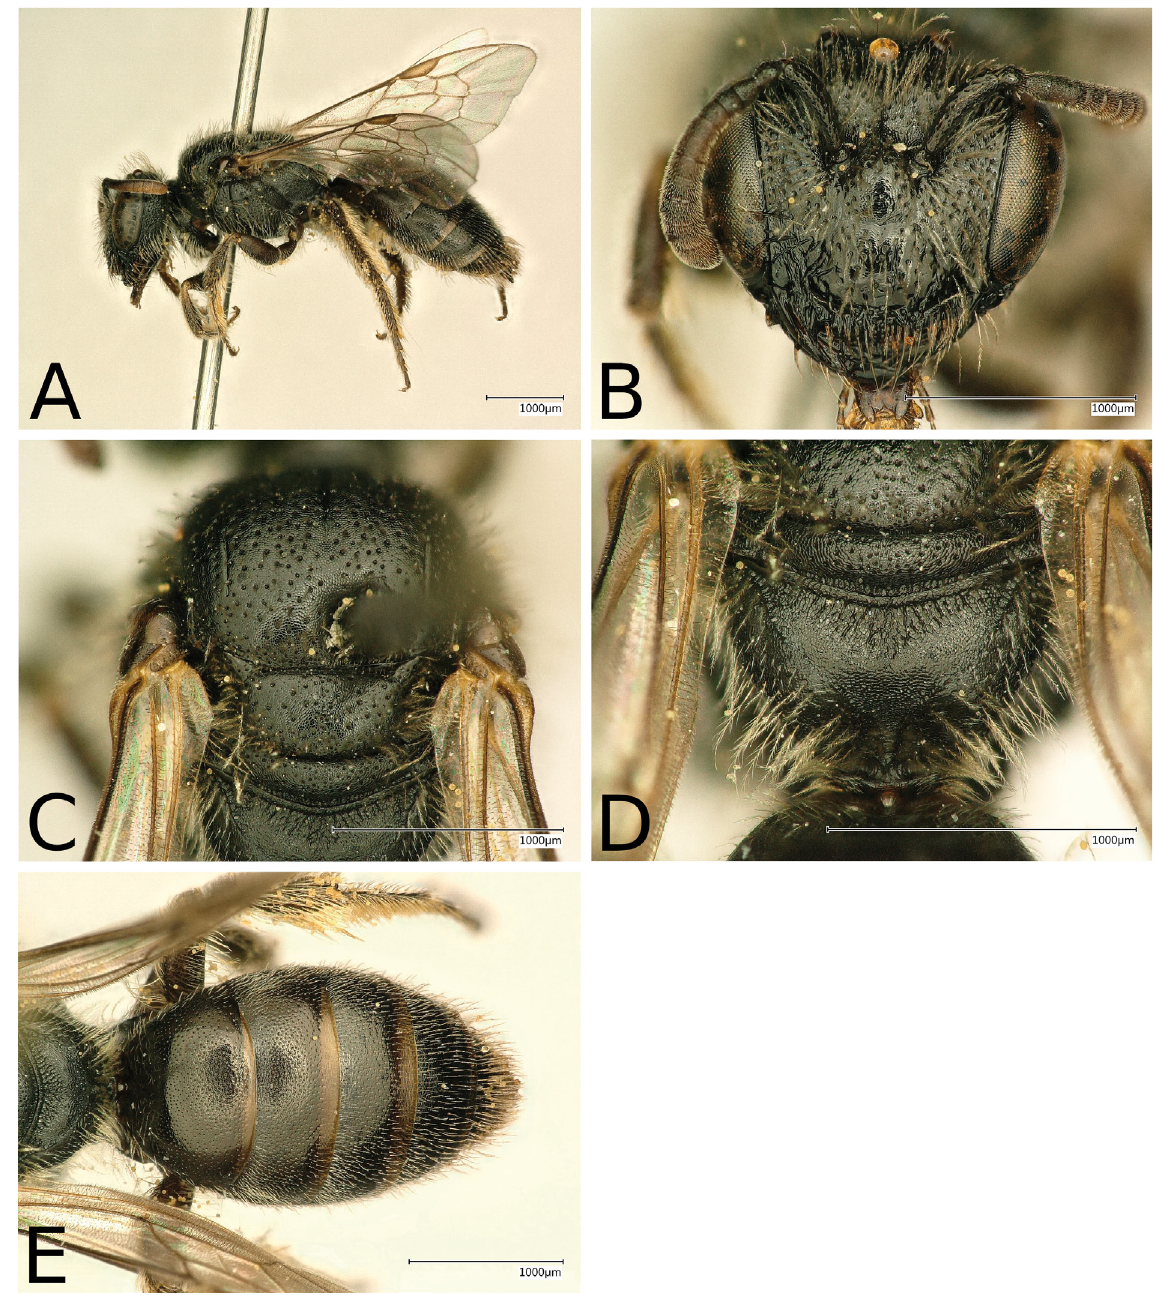
Fig. 3. Scrapter fynbosensis Kuhlmann sp. nov., ♀, holotype (RCMK). A . Lateral view. B . Head. C . Scutum and scutellum (dorsal view). D . Metanotum and propodeum (dorsal view). E . Metasoma (dorsal